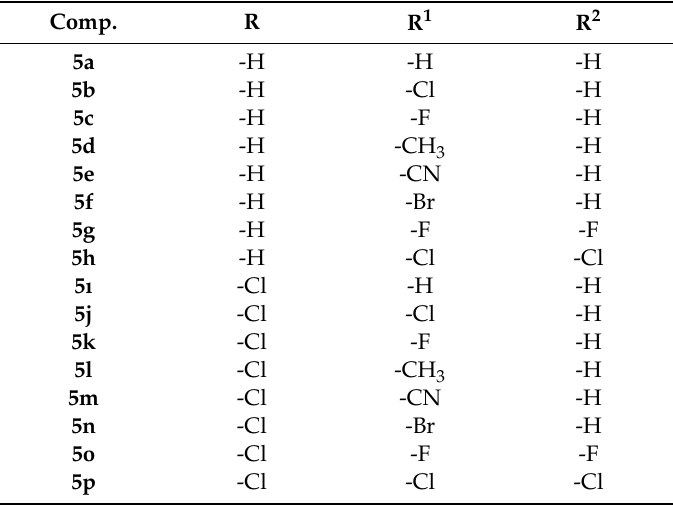
Table 1. The synthesized compounds ( 5a – 5p